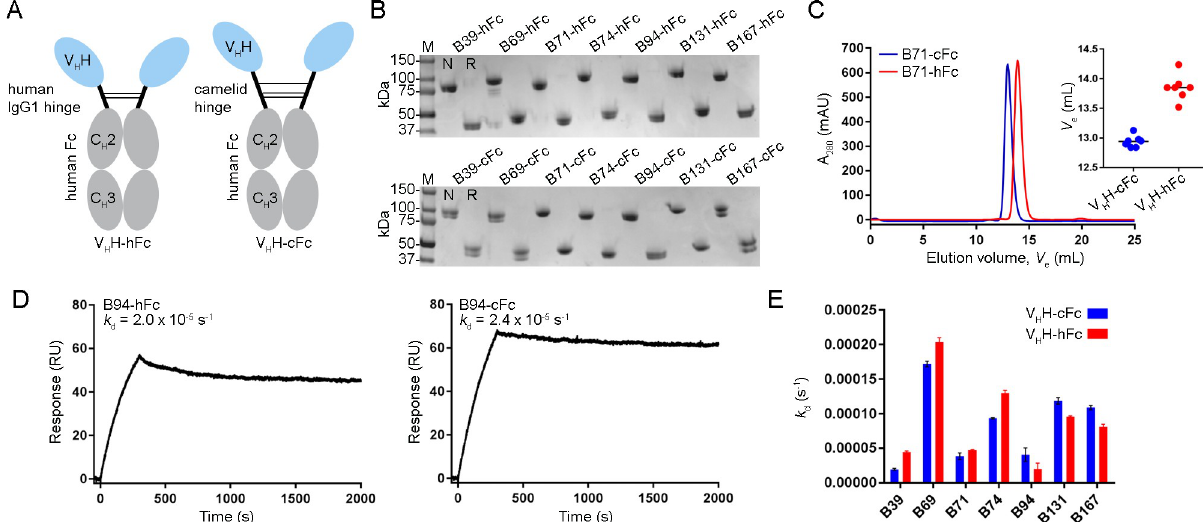
Fig 4. Generation and characterization of V H H-Fcs with human or camelid hinges. (A) Cartoon diagram illustrating the two V H H-Fc formats used with varying hinge length and composition. (B) Purified V H H-Fcs were analyzed by SDS-PAGE under non-reducing (N) and reducing (R) conditions. (C) Representative V H H-Fc SEC elution profile from a Superdex 200 column. Inset , plot of SEC elution volumes for all V H H-cFcs and V H H-hFcs. (D) Representative SPR sensorgrams showing 30 min (1800 s) dissociations of V H H-Fc fusions flowing over immobilized TcdB 1751-2366 surfaces. (E) Dissociation rate comparison of V H H-Fcs with human or camelid